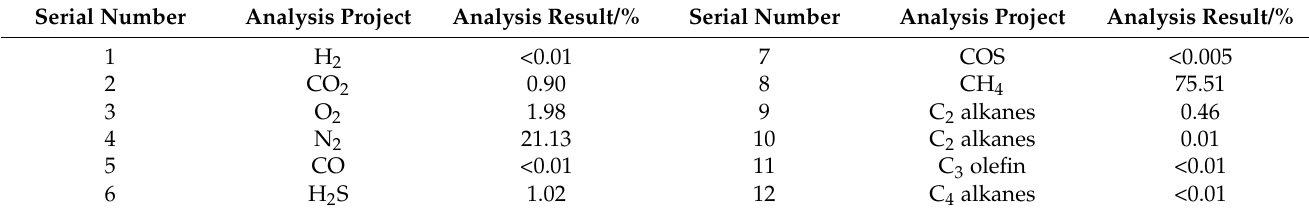
Table 3. Analysis results of borehole gas 41 m to the south from the abandoned oil well of ma tan